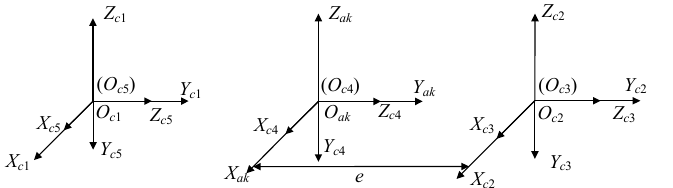
Figure 6. The coil array fixed coordinate system and the single coil fixed coordinate system.